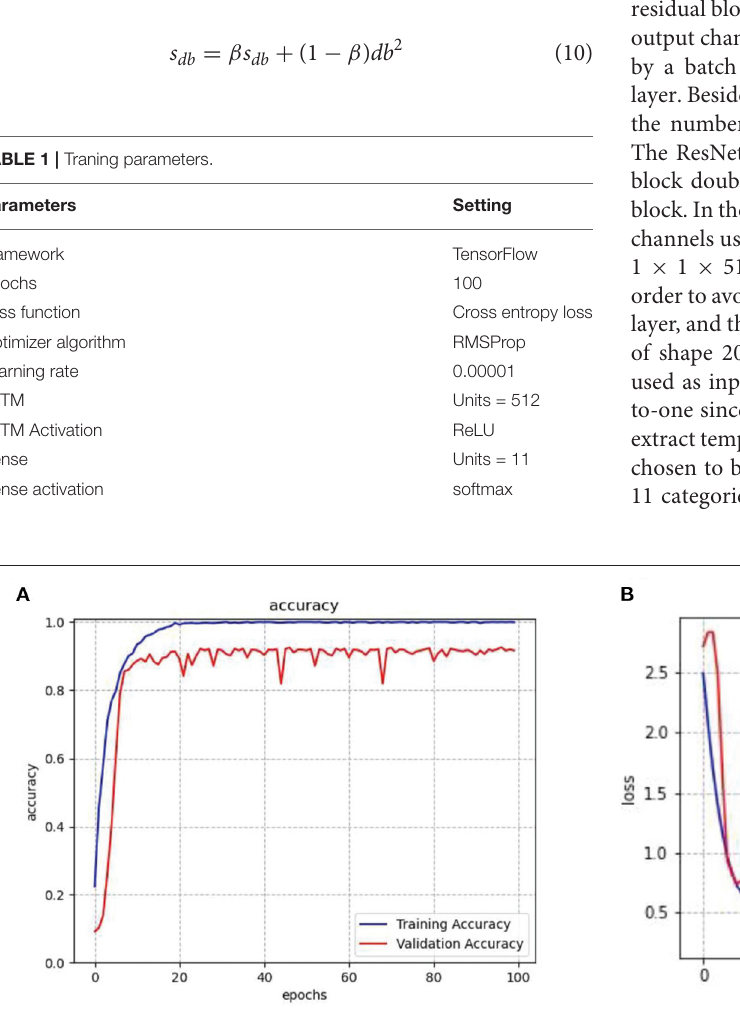
Frontiers in Neurorobotics |